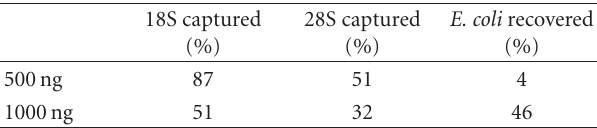
Table 2: Capture e ffi ciency of 18S and 28S ribosomal RNA and recovery of E. coli RNA using a single-step capture protocol on a selective solid phase.